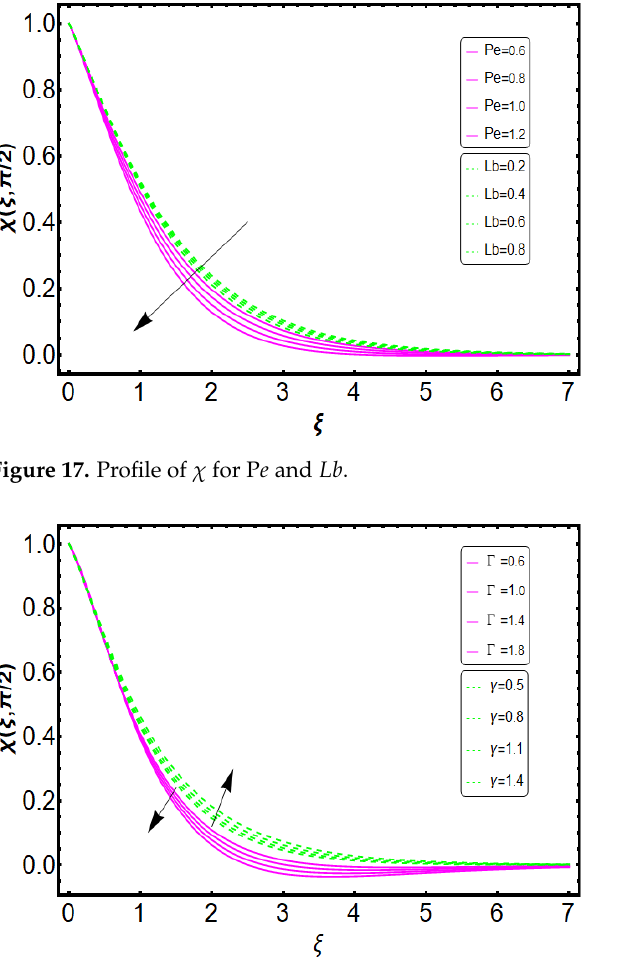
Γ χ γ Γ χ γ Γ and γ . for and . Figure 18. Profile of χ for for and .